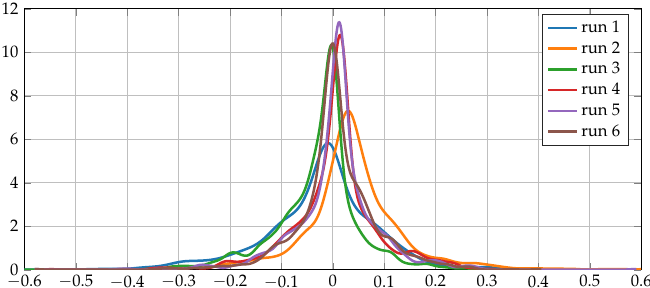
− I ( k ) ) of each neural network ( k )